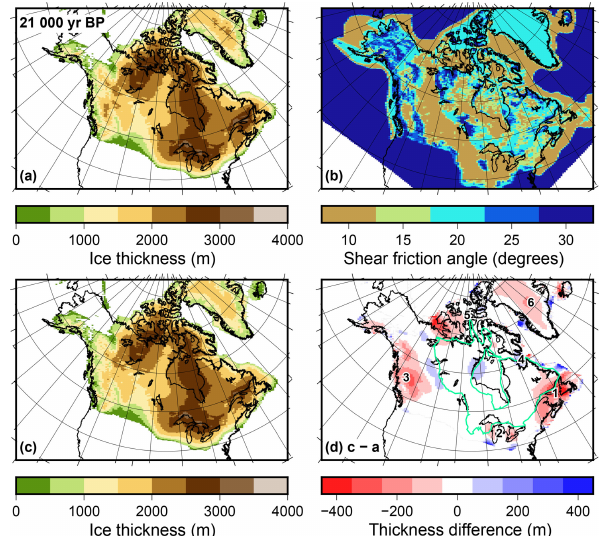
Figure 8. Impact of the distribution of sediments on the sim- ulation of North American ice sheets. (a) Thickness of the ice sheets at 21000yrBP (after about 101000 years of simulation) with the default shear friction angle, φ = 30 ◦ . (b) Shear friction angle adjusted downwards for sediment cover. (c) Ice thickness at 21000yrBP using the shear friction angle shown in (b) . (d) Differ- ence in ice thickness between (a) and (c) . The numbers in (d) rep- resent areas mentioned in the text: (1) eastern Canada, (2) Great Lakes, (3) Cordillera, (4) Hudson Strait, (5) Arctic Archipelago and (6) Greenland. The green outline shows the exposed limit of the Canadian